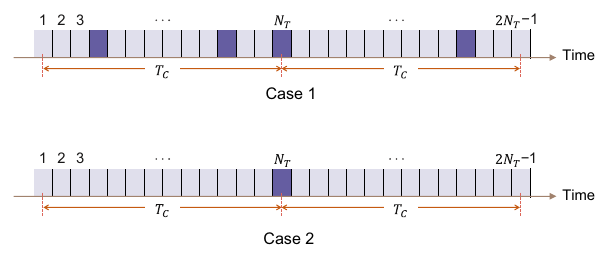
FIG. 2. Schematic of case 1 and case 2. Each time bin is rep- resented by a lattice, and detection events are painted in deep purple. Case 1: a detection event around which other detection events can be found within T c ; case 2: a detection event around which there are no other detection events within T c . Here N T is the total number of pulses sent within T c , which is proportional to the system repetition rate.